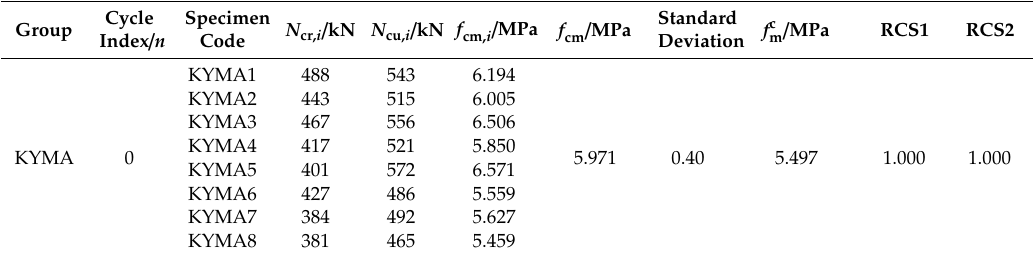
Table 8. Comparison of average compressive strength between calculated values and measured values.